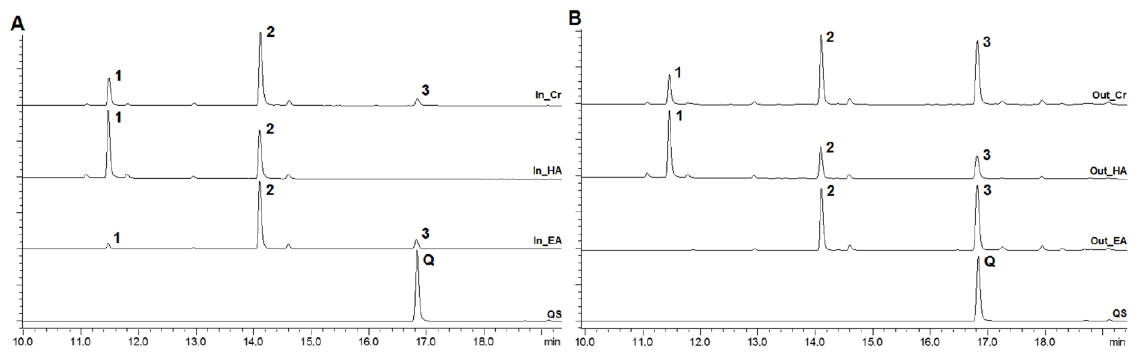
Figure 2. Chromatograms of Allium cepa inner (In) and outer (Out) extracts and their respective fractions. ( A ) Inner crude extract (In_Cr); Inner hydroalcoholic fraction; (In_HA); Inner ethyl acetate fraction (In_EA) and Quercetin standard (QS). ( B ) Outer crude extract (Out_Cr); Outer hydroalcoholic fraction (Out_HA); Outer ethyl acetate fraction (Out_EA) and Quercetin standard (QS). Peaks 1 and 2 correspond to quercetin glycosides; peak 3 corresponds to quercetin; peak Q corresponds to quercetin standard, at the wavelength of 370 nm.